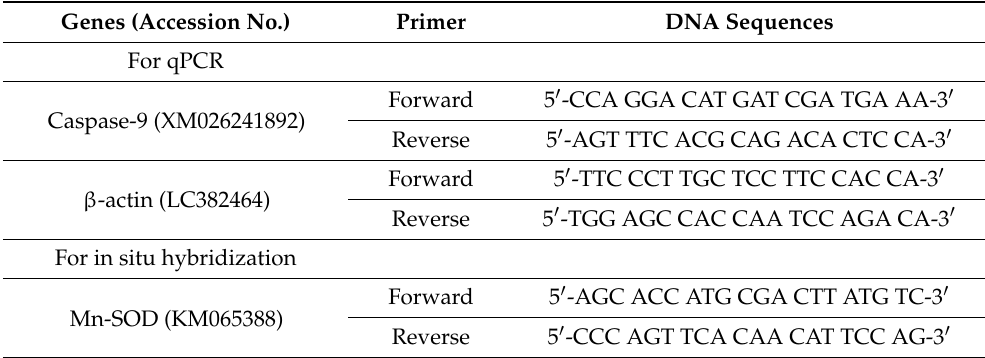
Table 1. Primers used for qPCR amplification and in situ hybridization. Genes (Accession